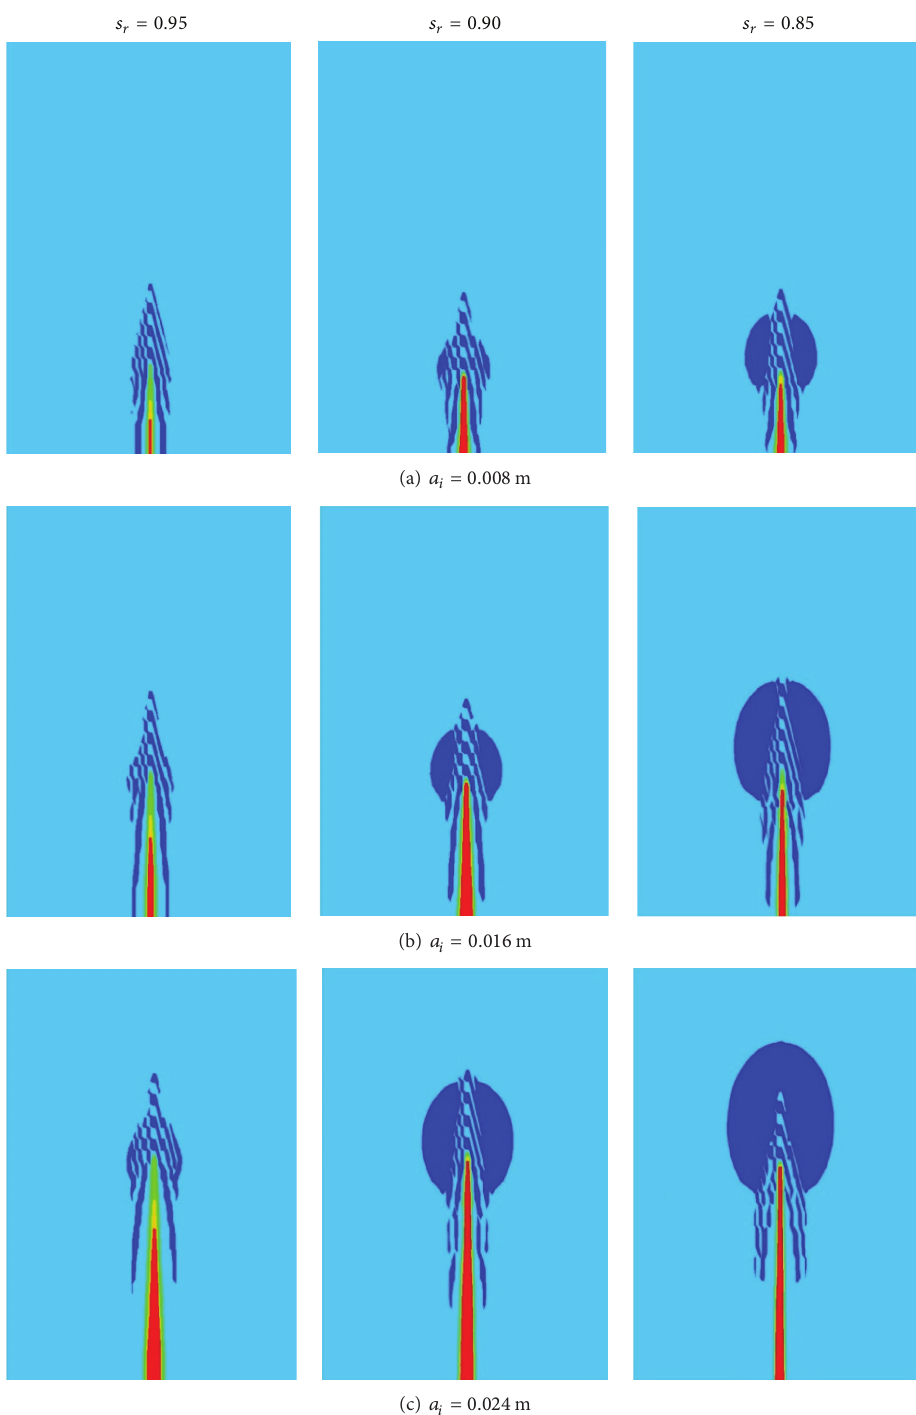
Figure 4: Negative pore pressure zone (dark blue color) at different saturations arranged in columns.